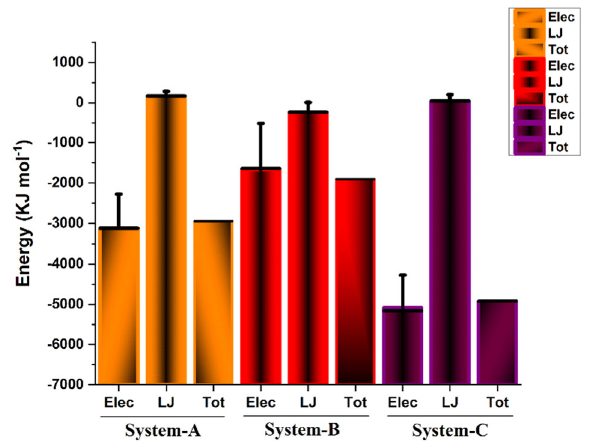
Fig. 4 The interaction energy between water molecules and AWC. The error bars represent the standard deviations of the data.